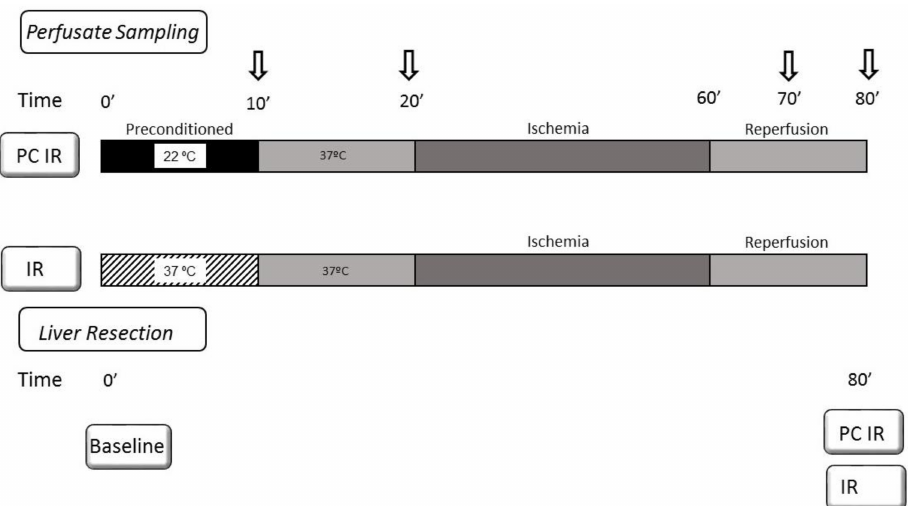
Figure 1. Schematic representation of experimental design. The IPR livers were